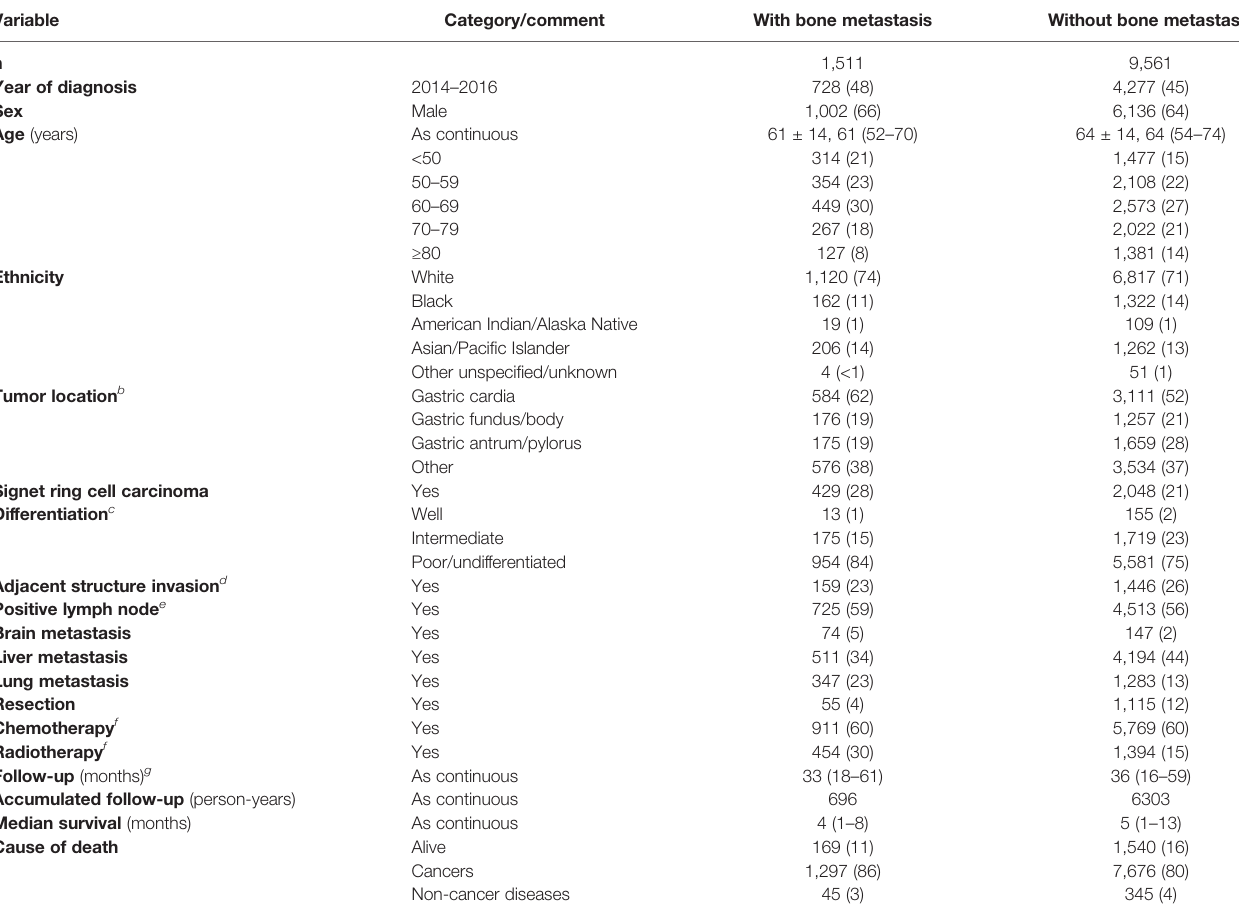
TABLE 1 | Baseline characteristics of patients with metastatic gastric adenocarcinoma (with and without bone metastasis), 2010 – 2016 a